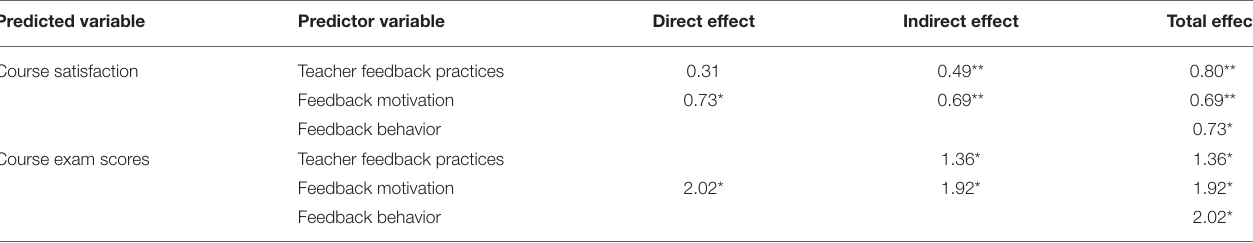
TABLE 5 | Unstandardized direct, indirect, and total effects for structural model of non-key university. Predicted